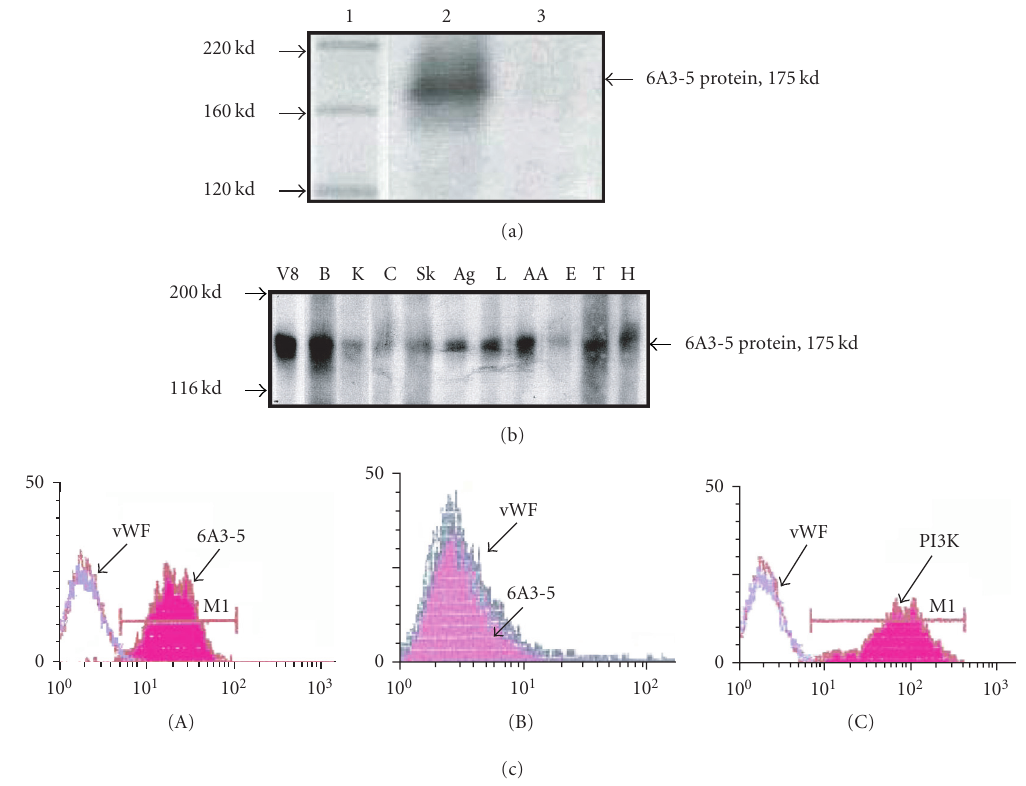
Figure 7. Structural characterization of 6A3-5 protein by western blot and FACScan. (a) Polyclonal antibodies directed against 6A3-5 bound, by western blot, to a unique band migrating with an apparent molecular weight of 175 kd. Lane 1, molecular weight markers; lane 2, V8 SMCs with anti-6A3-5 Ab; lane 3, V8 SMCs with rabbit anti-vWF polyclonal antibody. (b) Western blot analysis of the 6A3-5 protein in di ff erent rat tissues. A unique band of 175 kd, corresponding to the 6A3-5 protein, was observed in all analyzed rat tissues, but at di ff erent levels of expression. Sizes of molecular weight markers are shown on the left (in kd). Lane V8, proliferating V8 cells; lane B, brain; lane K, kidney; lane C, cerebellum; lane Sk, skeletal muscles; lane Ag, adrenal gland; lane L, lung; lane AA, aorta and aortic arch; lane E, eyes; lane T, testis; lane H, heart. The blot contained the following amounts of total protein extracts: lane V8, 30 µ g; lanes B to L, 50 µ g; Lanes AA to H, 80 µ g. (c) FACScan confirmed the specificity of polyclonal antibodies raised against 6A3-5 protein. In addition, the protein was only labeled by the antibody when SMCs were permeabilized. This suggests that the protein has an intracellular localization. (A) Permeabilized SMCs with anti-6A3-5 Ab, (B) nonpermeabilized SMCs with anti-6A3-5 Ab, (C) permeabilized SMCs with anti-PI3Kinase Ab as a positive control. Anti-vWF represents the negative